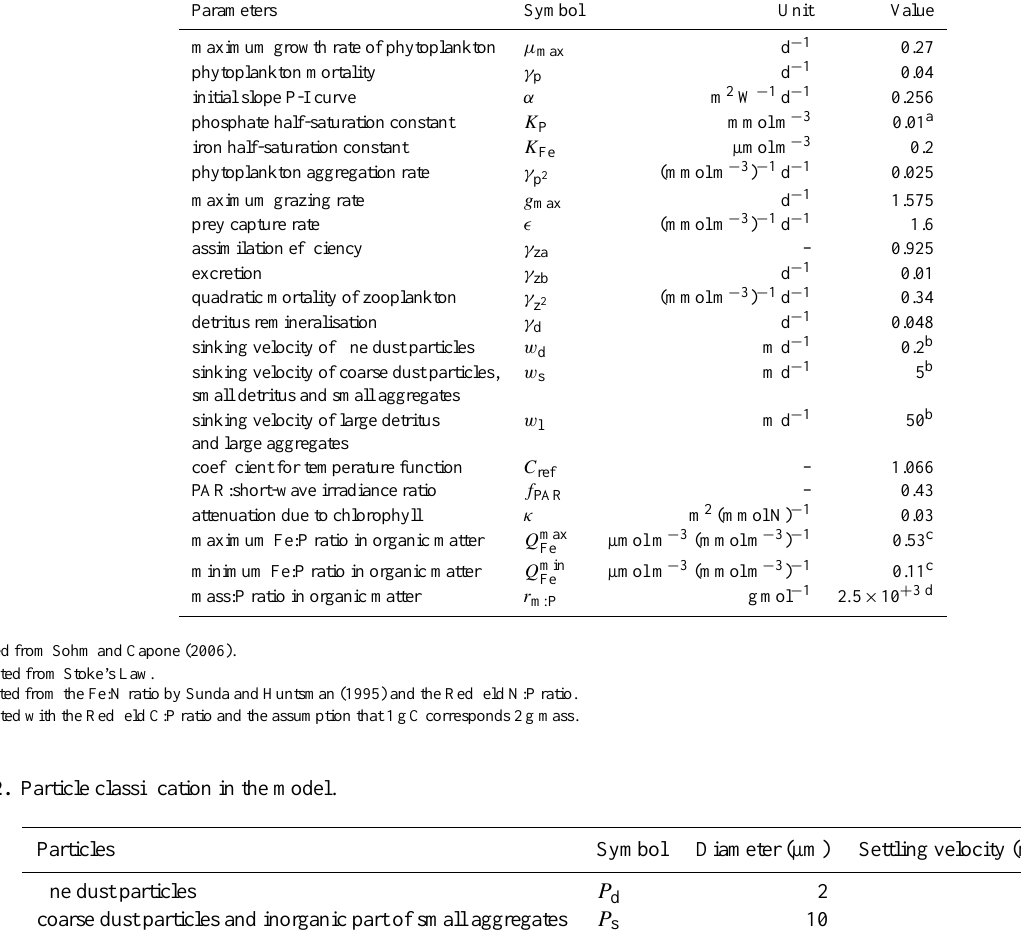
Table 2. Particle classification in the model. Particles fine dust particles 0.2 coarse dust particles and inorganic part of small aggregates P s small detritus and organic part of small aggregates D s inorganic part of large